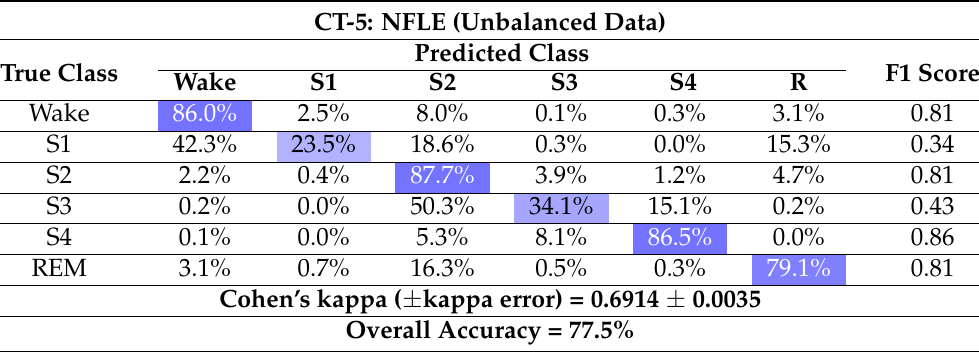
Table 17. Confusion matrix corresponding to sleep stage classification of nocturnal frontal lobe epilepsy patients with unbalanced data using the EBT classifier with 10-fold CV.